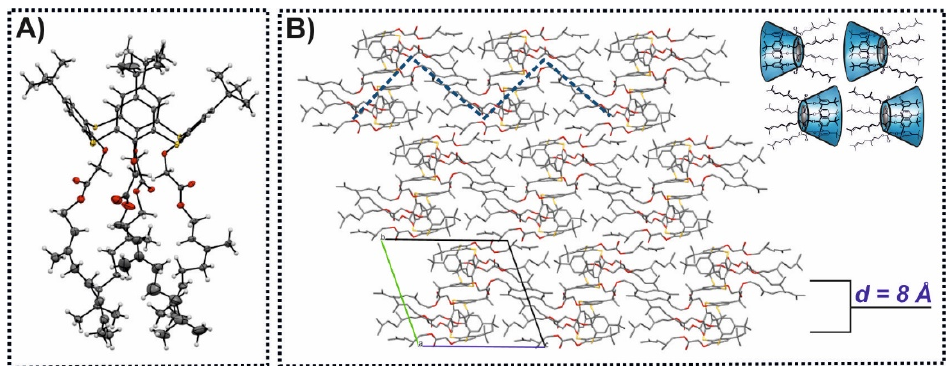
Figure 2. X-ray structure of 4 ( A ) showing cone conformation (gray—carbon atoms, white - hydrogen atoms, yellow—sulfur atoms, red—oxygen atoms) and crystal packing (the parallelogram is the elementary cell, and the dashed line represents the zigzag packing) ( B ). H atoms and disorder are not presented for clarity in ( B ).